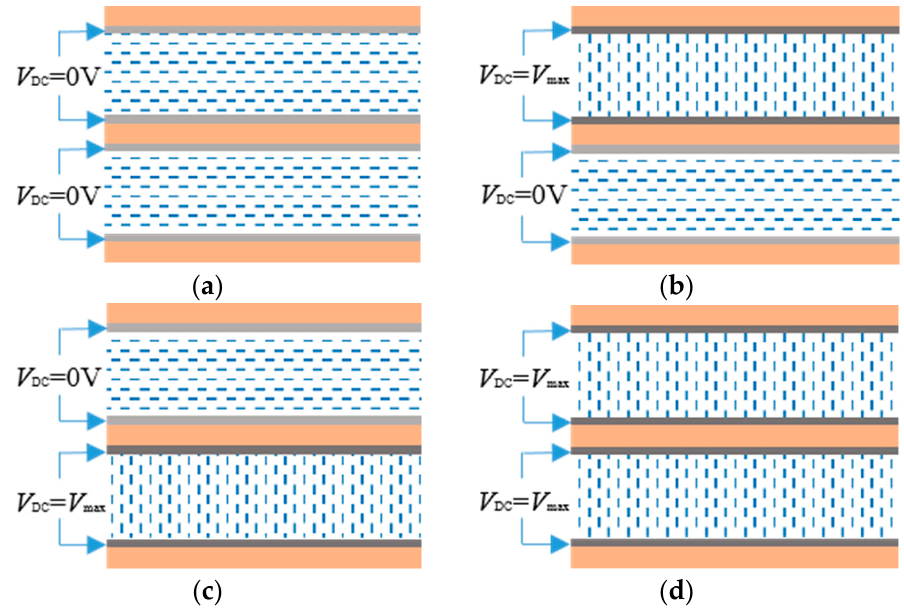
Figure 2. Schematic diagram of four different states of dual-tuned mode based on ( a ) alignment of two LC layers, ( b ) loading bias voltage on the first LC layer, ( c ) loading bias voltage on the second LC layer and ( d ) loading bias voltage on two LC layers.